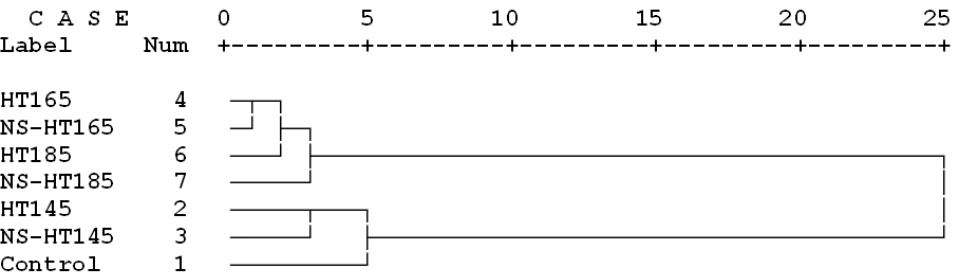
Figure 9. Cluster analysis based on four physical and four mechanical properties, as well as crystallinity values of the seven treatments studied in the present project (HT = heat ‐ treated at a determined temperature; NS = nano ‐ silver impregnated).